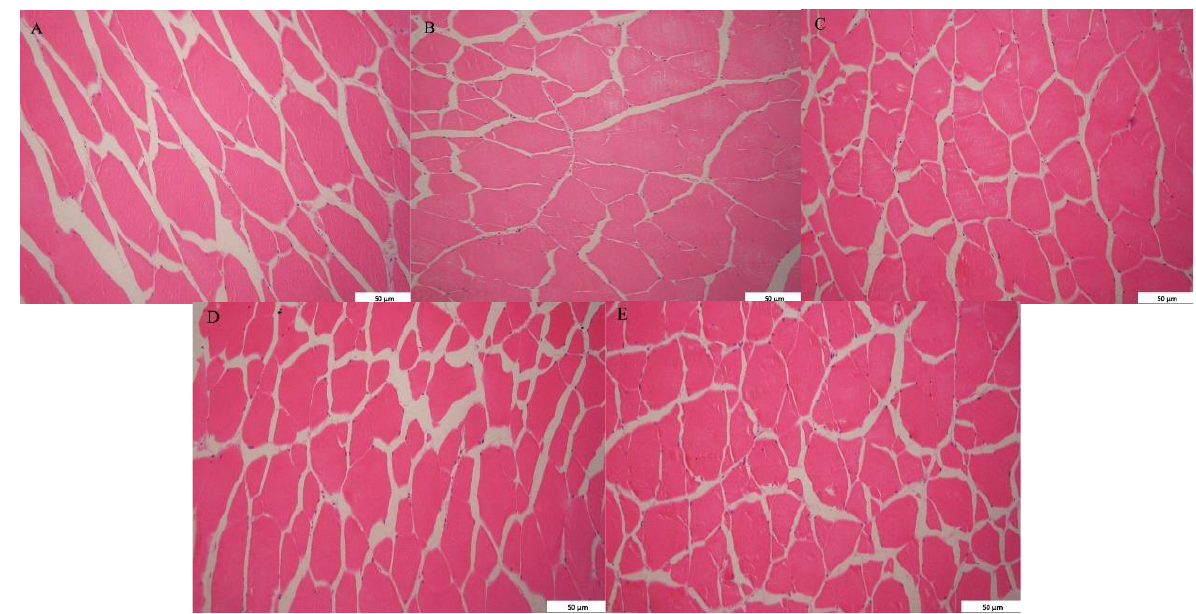
Figure 2. The morphology of the muscle of grass carp fed a diet with paper mulberry (BP) for 8 weeks. ( A ) Control diet 200 × ; ( B ) 5%BP group 200 × ; ( C ) 10%BP group 200 × ; ( D ) 15%BP group 200 × ; ( E ) 20%BP group 200 × .